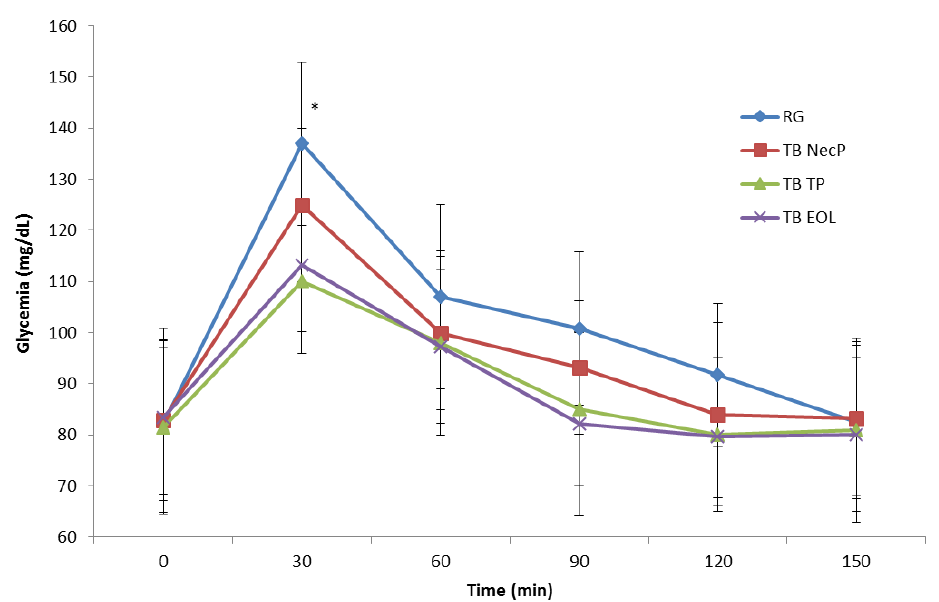
Figure 1. Change in postprandial plasma glucose concentration in healthy adults for the three treatment beverages. TB NecP (2 g of NecP, equivalent to 14 µg ABA); TB EOL (400 mg EOL, equivalent to 60.0 mg oleuropein); TB TP (2 g TP, equivalent to 1.0 mg total carotenoids). Data are mean ± SD. * Indicates a significant difference between peak 30 min glucose concentration for each treatment test compared to the reference test ( p < 0.05). Abbreviations: RG, regular glucose solution; NecP, nectarine dry extract powder; TP, dried tomato peel powder; EOL, ethanol extract from olive leaves.